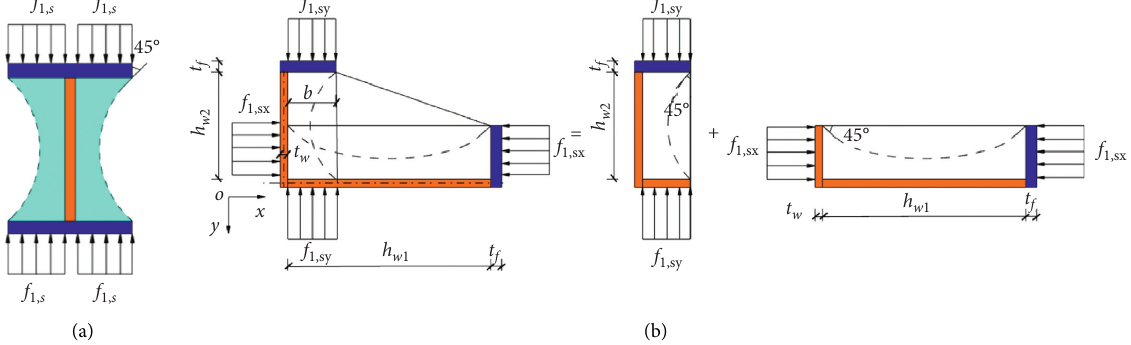
Figure 14: Effective region of confined concrete for (a) H-shaped steel and (b) monosymmetric cross-shaped